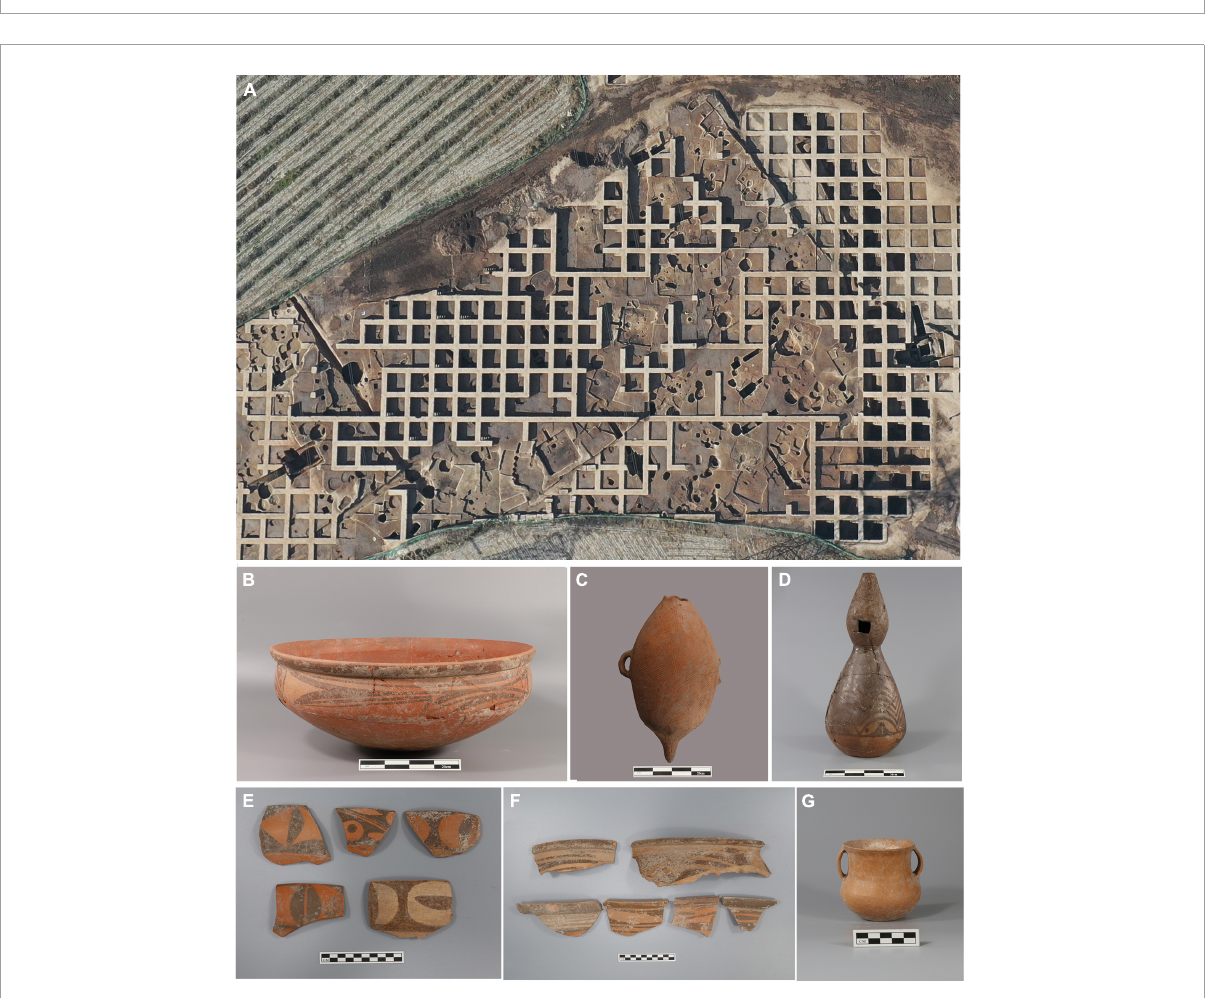
FIGURE2 Excavation site of ring trench settlement and representative pottery of various cultural periods. (A) ring trench settlement. (B–D) pottery of the Banpo Phase of Yangshao Culture. (E) Painted pottery of the Maodigou Phase of Yangshao Culture. (F) Painted pottery of the Late Yangshao Culture. (G) Pottery of the Qijia